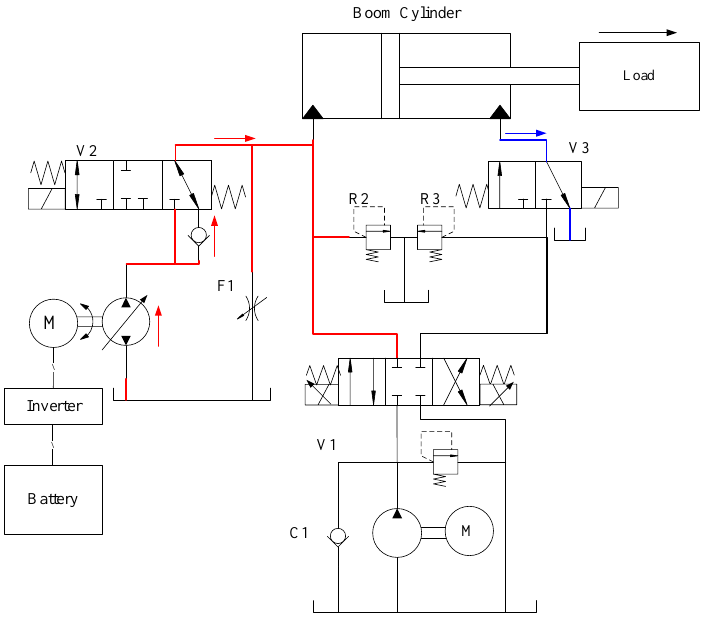
Figure 5. Stored energy used to drive boom cylinder upward in reuse mode.